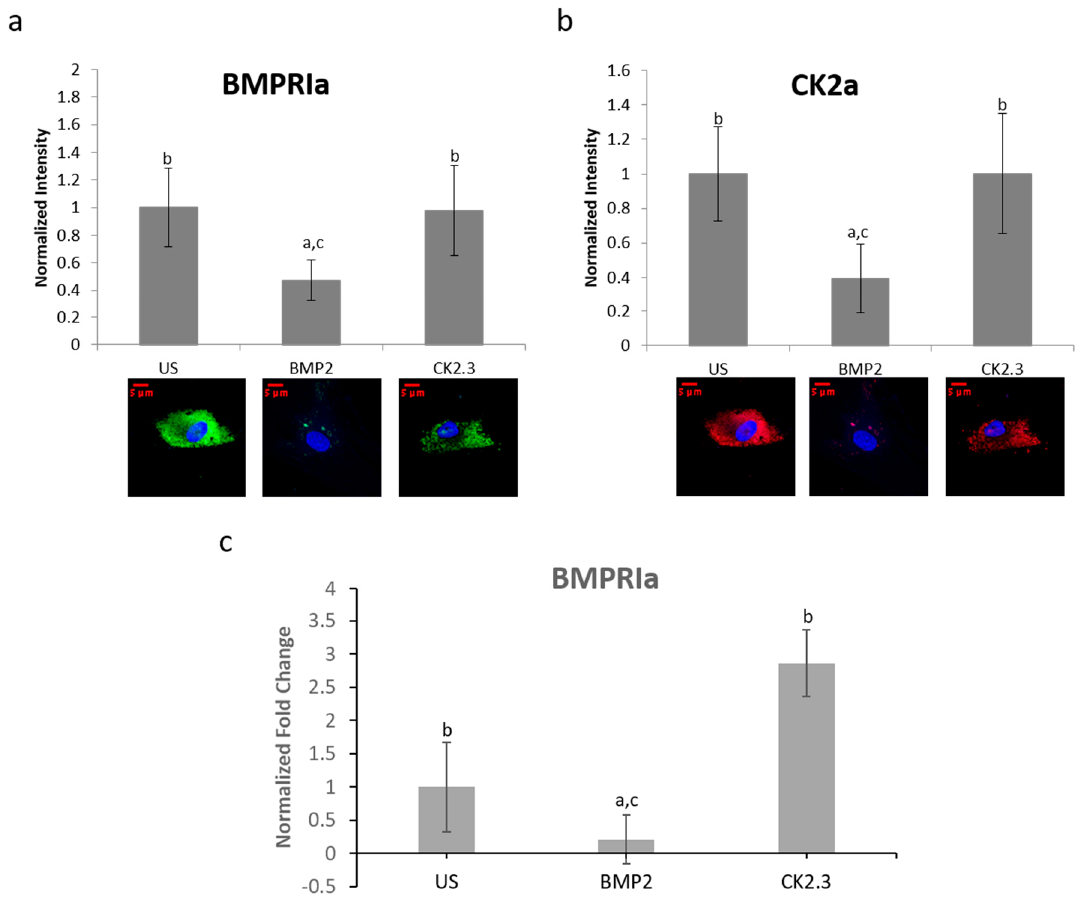
Figure 7. Osteoblasts extracted from OP patients were stimulated with BMP2, CK2.3, or left US for five days. After the fifth day, the cells were fixed and stained for BMPRIa (green), CK2 α (red), and the nucleus (blue). ( a ) CK2.3 and US cells significantly increased expression of BMPRIa when compared to BMP2 stimulation. ( b ) BMP2 stimulation significantly decreased expression of CK2 α when compared to CK2.3 and US cells. ( c ) RNA was extracted from OP patients’ osteoblasts after they were stimulated with BMP2, CK2.3, or left US for five days. BMP2 significantly decreased BMPRIa gene expression when compared to US and CK2.3 stimulated cells. Error bars represent standard error of the mean (SEM). “a” denotes statistically significant to US, “b” denotes statistically significant to BMP2, and “c” denotes statistically significant to CK2.3 ( p < 0.05).